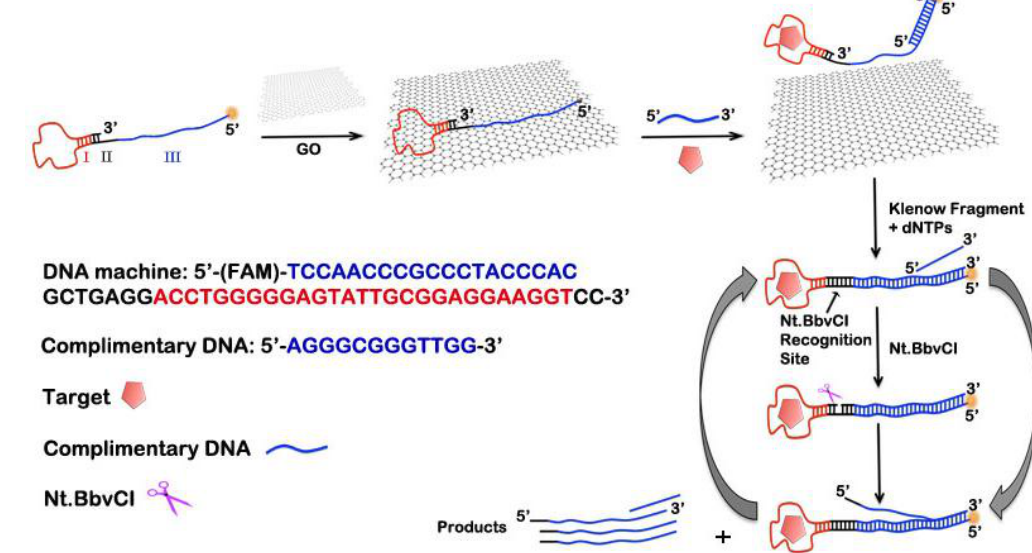
Figure 1. Schematic illustration of the graphene-based biosensing platform based on regulated release of an aptameric DNA biosensor and the amplification detection of target (ATP). This involves two principal steps: (1) the effective absorption of DNA biosensor by GO and regulated release of the DNA biosensor from GO in the presence of target; and (2) the polymerization/nicking enzyme synergetic isothermal amplification whose products can be detected by adding in SYBR